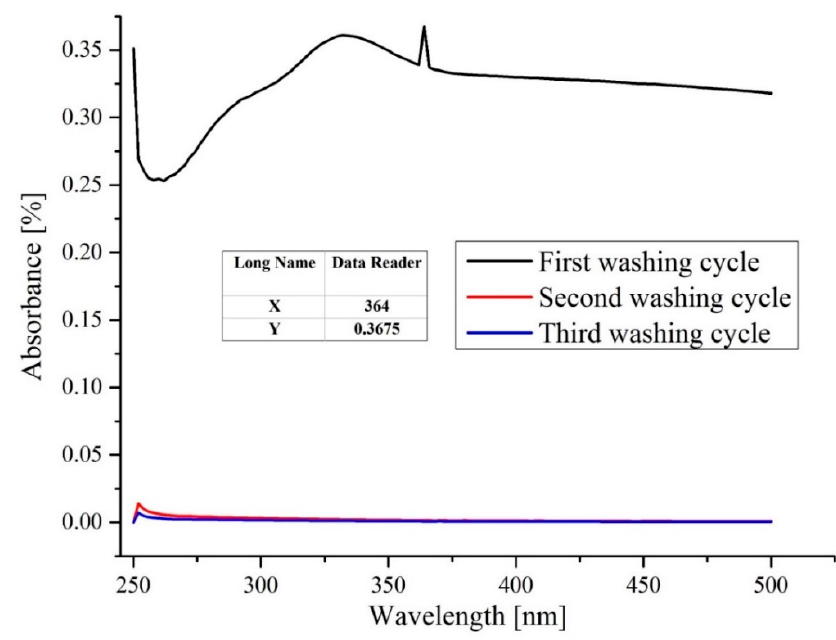
Figure 6. Absorbance spectra of C-nZnO 1 after different washing cycles.